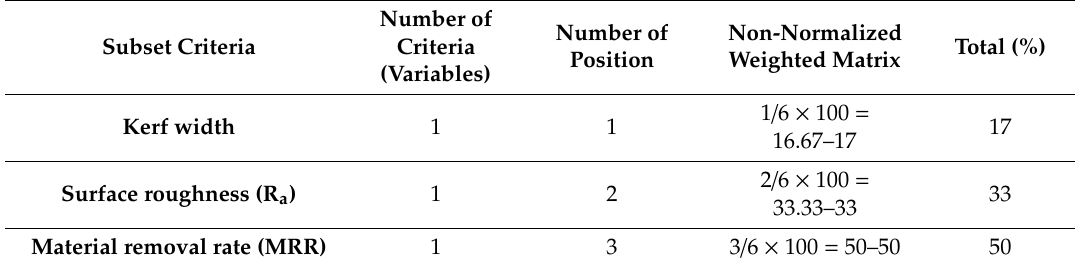
Table 8. Computational steps of the SIMOS weighting procedure for the wire electrical discharge machining cycle.